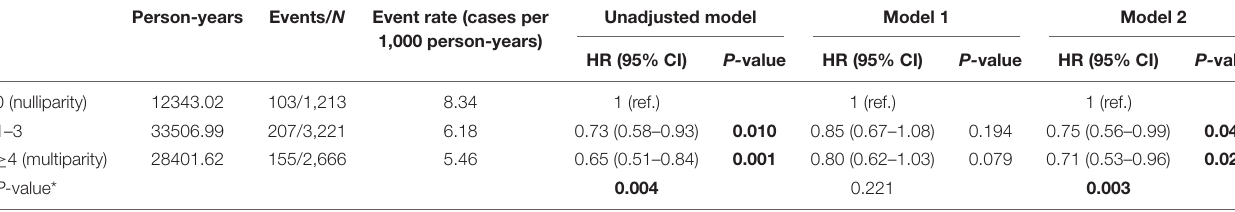
TABLE 2 | Hazard ratios and 95% confidence intervals for the associations between parity and the risk of MCI/dementia.